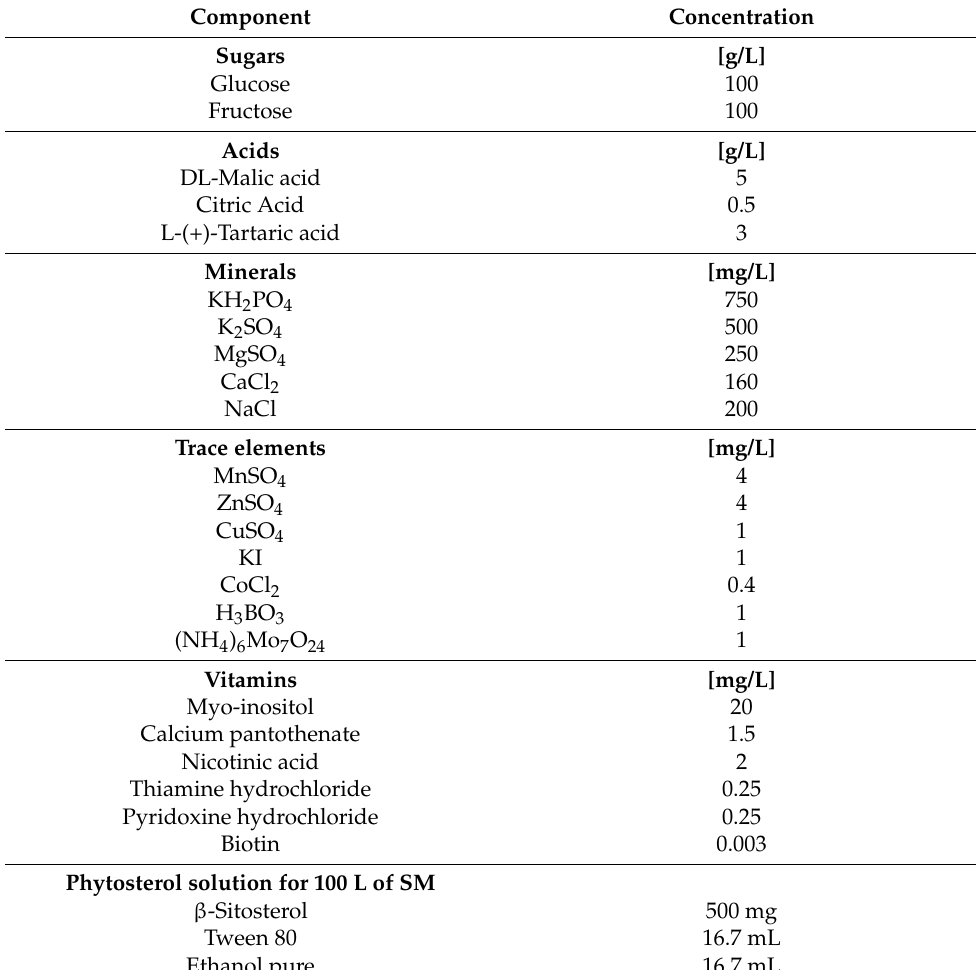
Table 2. Composition of the synthetic must base without the added amino acids. All chemicals were obtained from Merck (Darmstadt,